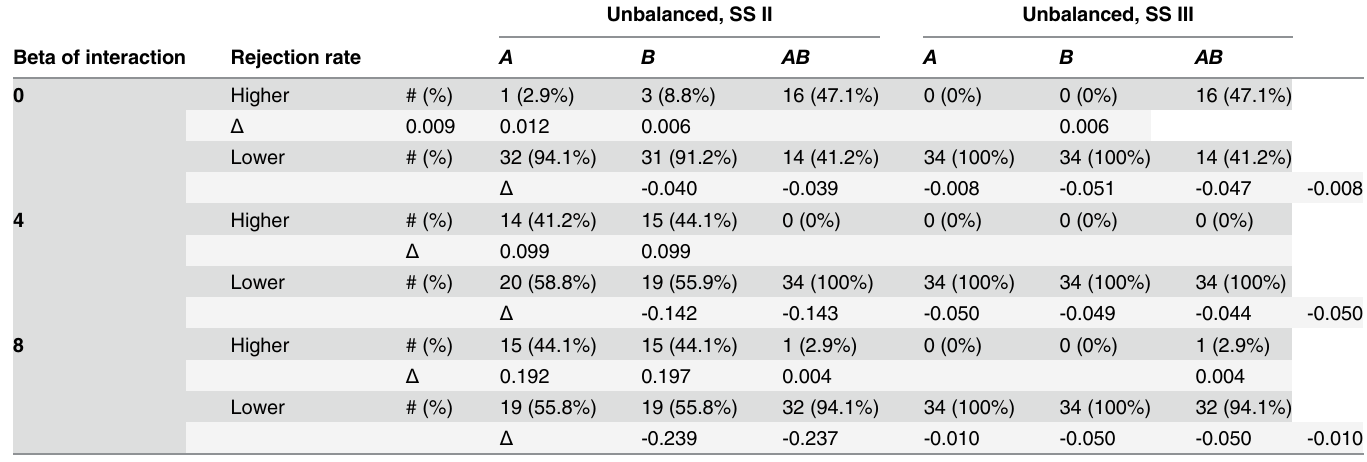
Table 6. Number of unbalanced designs (percentages of all 34 designs) with rejection rates of H0 that are higher or lower when compared to the re- jection rates of the balanced data (congruous data).